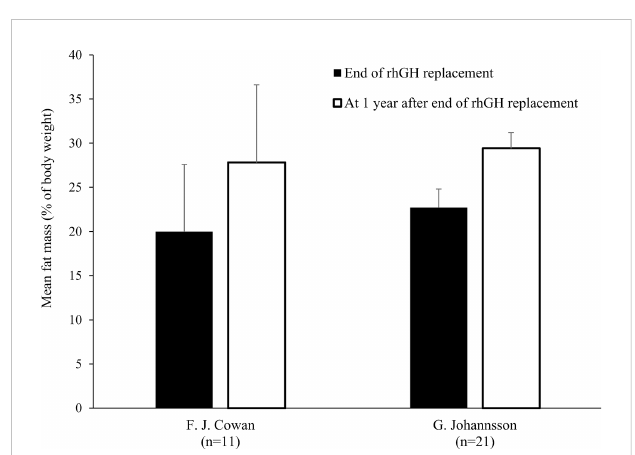
FIGURE 4 Fatmass(mean%ofbodyweightwithstandarddeviation)attheendofrhGH replacementand1yearlaterinpre-pubertalpatientswithGHD(19,23).GHD, growthhormonede fi